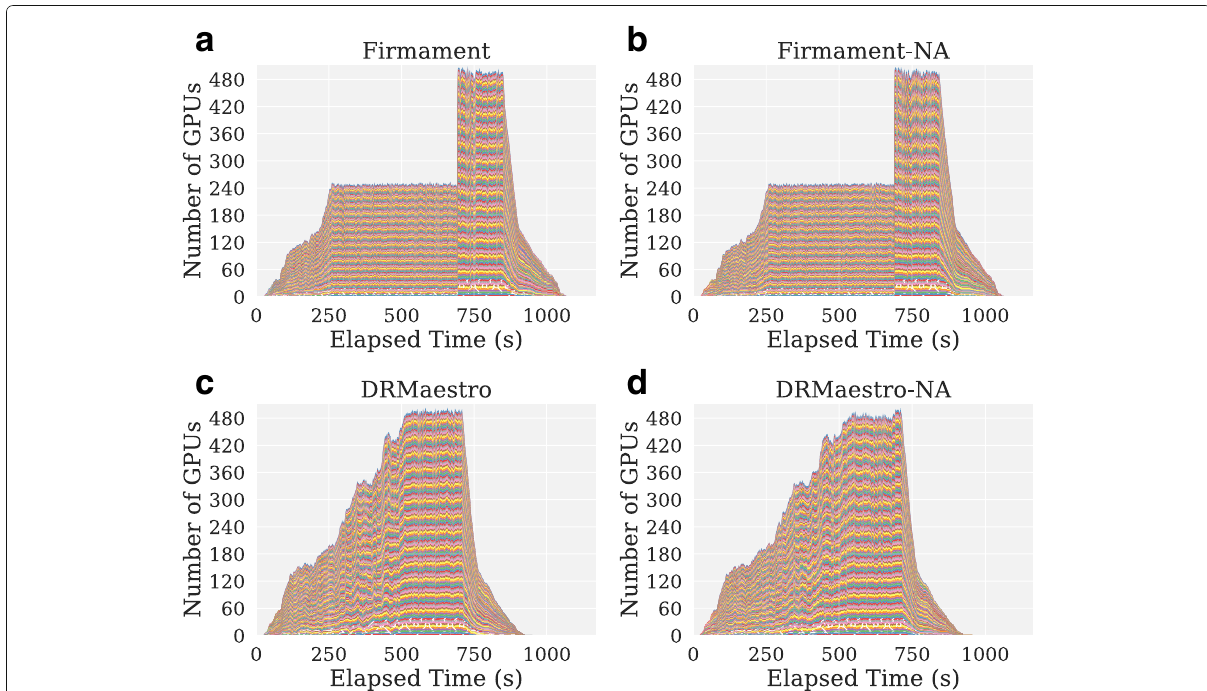
Fig. 9 Simulation results of orchestration with DRMaestro . Orchestration performed with DRMaestro with the implemented prototype in a cluster with 128 machines and 4096 jobs